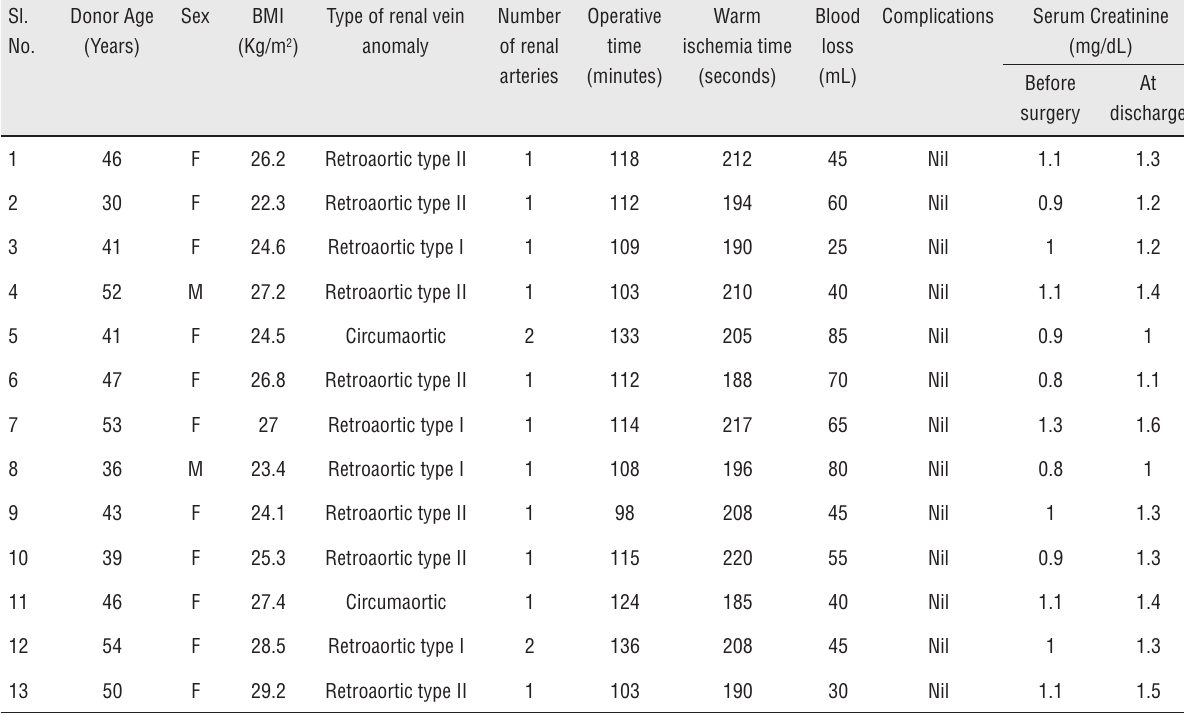
Table 1 - Donor characteristics.